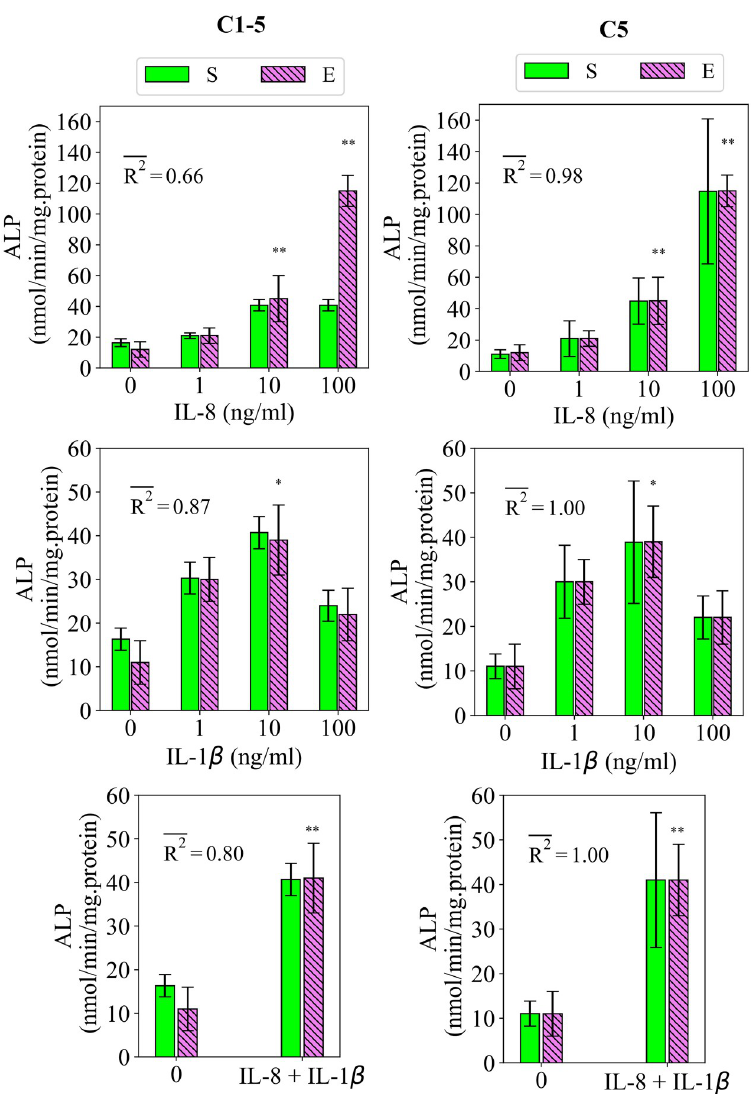
Fig 7. Fits of the model calibrated by C1-5 and C5 to the empirical data of study 5. Bars indicate the simulations (S) and the corresponding empirical data (E). The quantities of ALP are reported at day 9. The error bars on the empirical data shows the standard deviations. The error bars on the simulation results show the standard deviations obtained during SSIP, i.e. 15% alteration in the estimated parameter values. Stars indicate the statistically significant differences between values given for the empirical data compared to the control, i.e. the applied concentration of 0 ng/ml (p < 0.05 = � ; p < 0.01 = �� ). R 2 is the average fitness value of the simulations for the given measurement